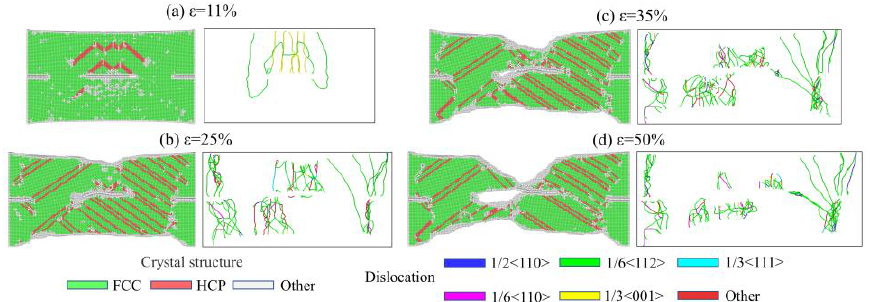
Figure 15. Crystal structure and dislocation line distribution of Gr/Cu-1 under different strains. ( a ) ε = 11%, ( b ) ε = 25%, ( c ) ε = 35% and ( d ) ε = 50%.